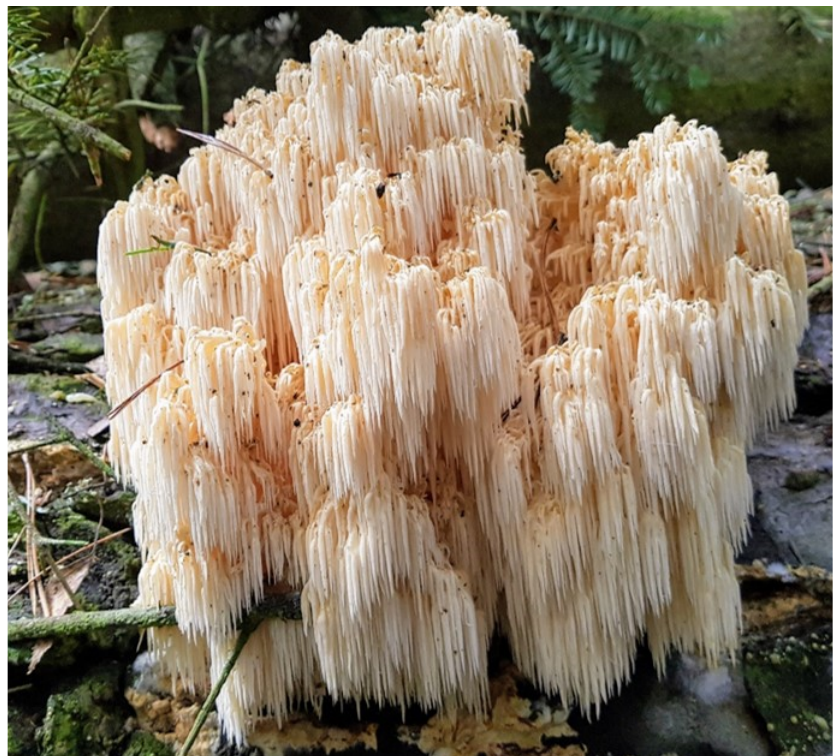
Fig. 2 Hericium flagellum basidioma growing on a fallen log of Abies alba in the “Olbina” nature reserve (November 9, 2017; photograph: M.